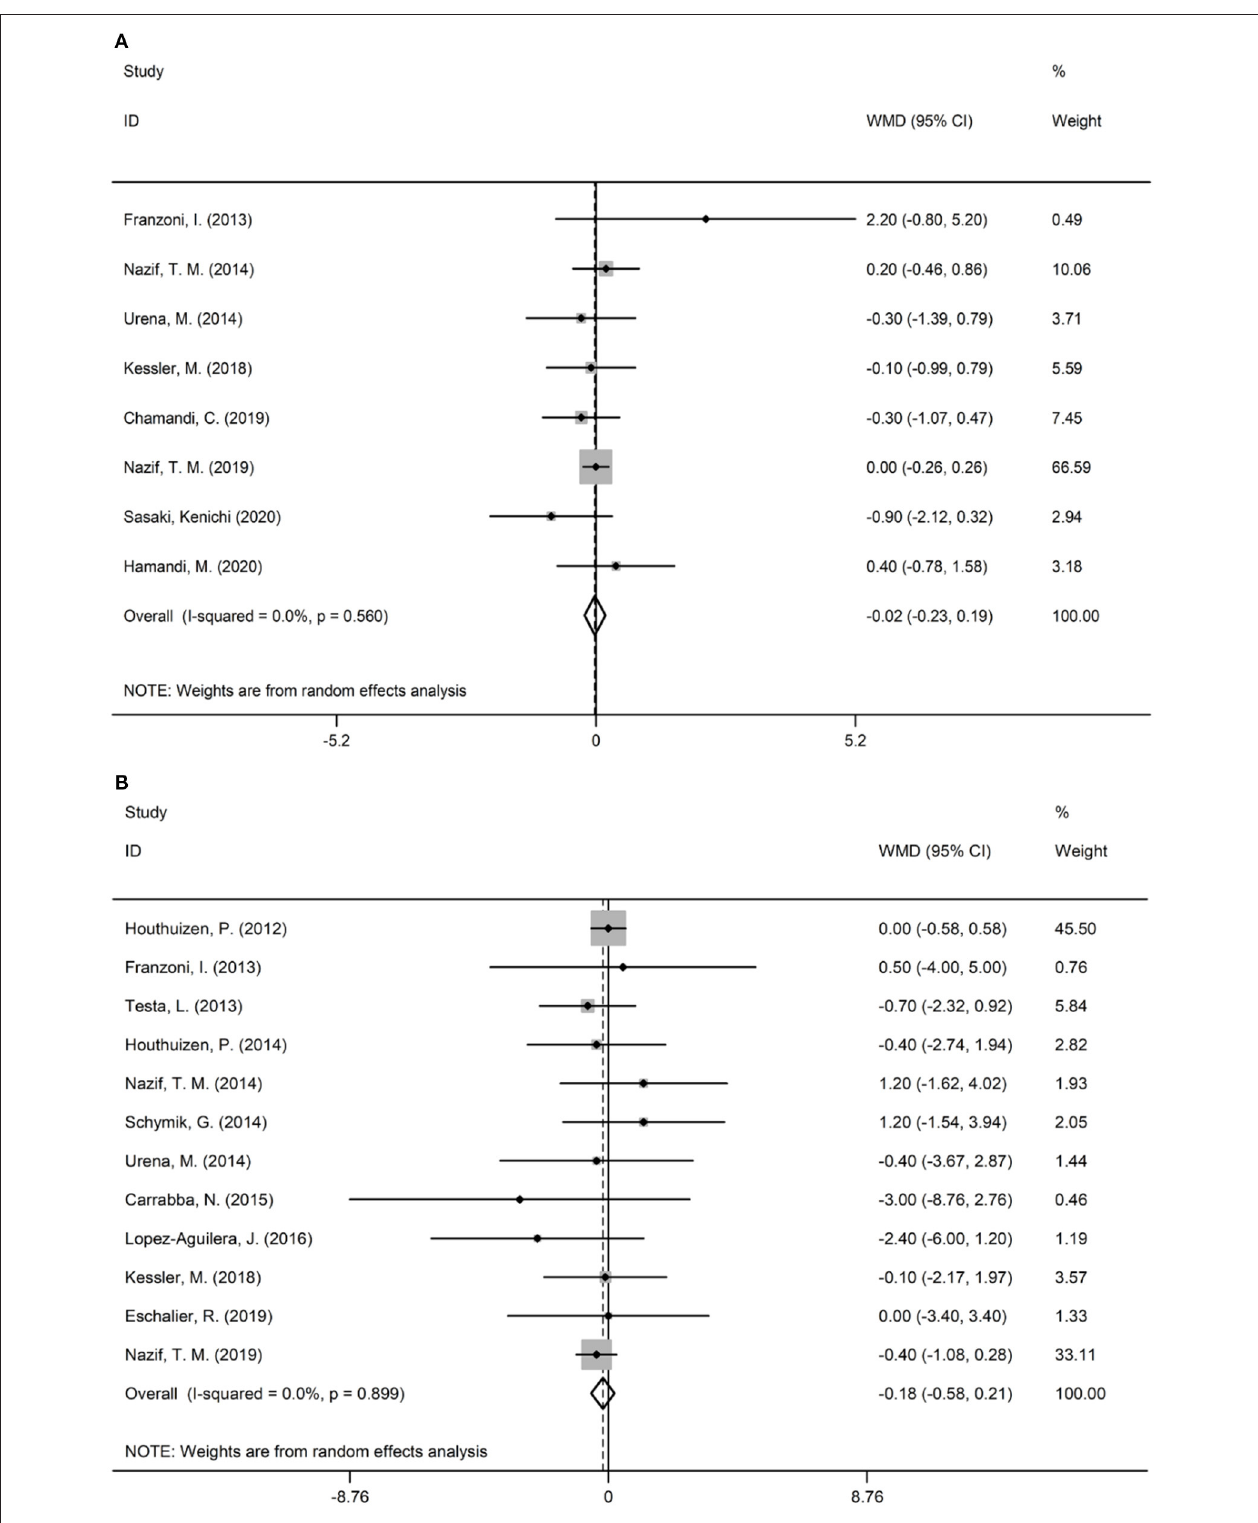
FIGURE 2 | Forest plots illustrating the surgical risk score. (A) STS score; (B) Logistic EuroSCORE.